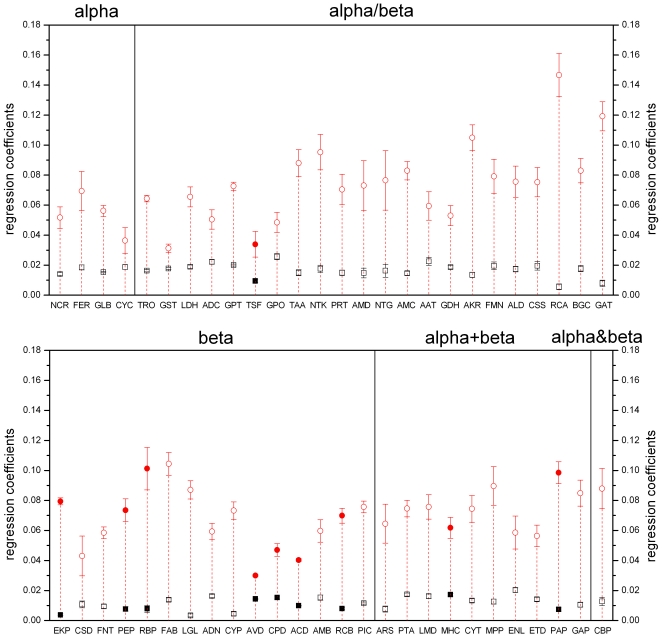
Neither SSS nor SIDS of 52 families is dependent on structural class.The figure shows SSS and SIDS (bilinear fit regression coefficients b1 and b2) and the standard deviation of these regression coefficients. Squares and circles represent SSS and SIDS respectively. Filled squares or circles indicate families where the average number of disulfide bonds is 1.5 or more; open squares or circles represent families with less than 1.5 disulfide bonds on average. Five regions corresponds to 5 SCOP structure classes. Family names are abbreviated as in Table S1.